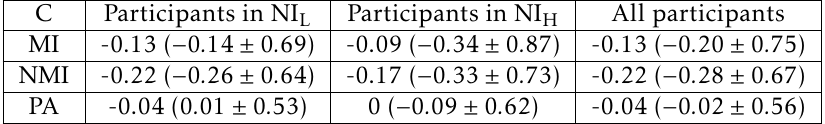
under different nudging conditions C ( w )